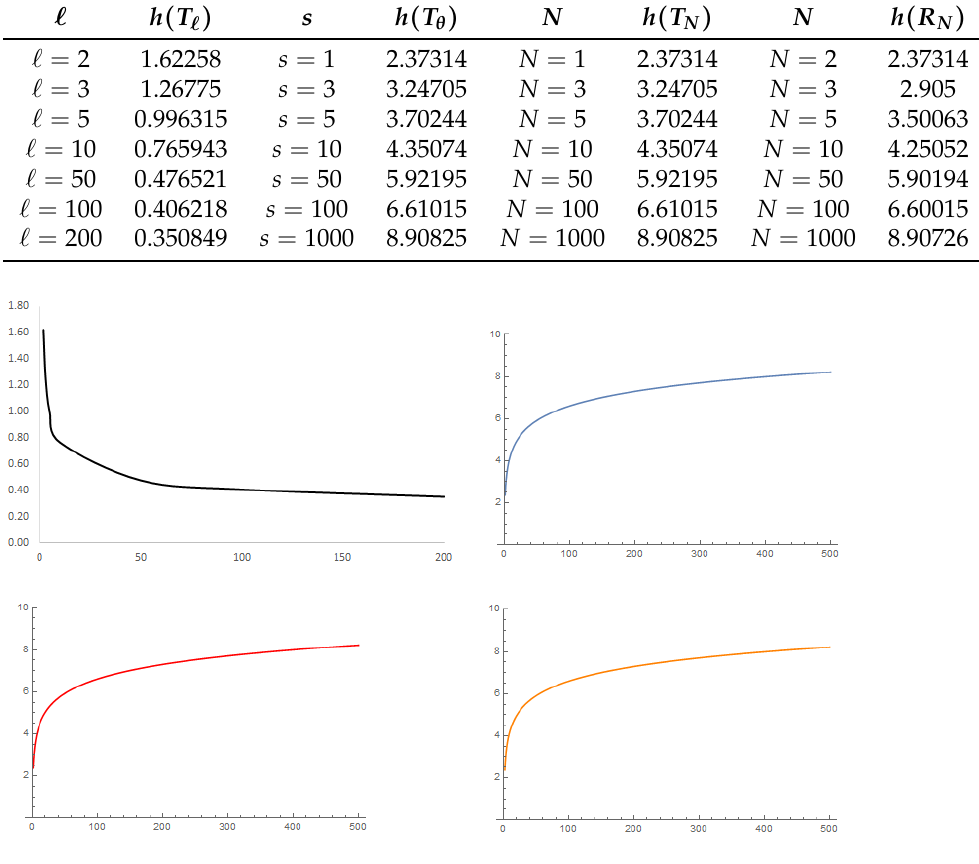
Table 1. Entropies h ( T (cid:96) ) , h ( T θ ) , h ( T N ) and h ( R N ) for different values of the parameters involved.